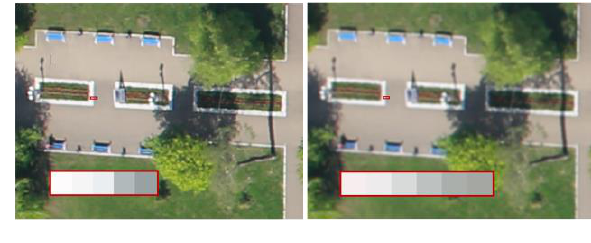
Figure 1. Fragments of aerial images with different sharpness (clarity): the sharpness of the right image is noticeably lower than that of the left image Visually, the blurriness of an image can be estimated by sharp edges of objects by visible pixelation at high magnification. The edge transition is a site of an image (a part of a row/column), containing the sharp change in pixels tone (values) from light to dark on a relatively small pixel interval (about several pixels) (Anikeeva, Kadnichanskiy, 2017). For images of visually high sharpness (clarity), the length of an edge transition does not exceed 5 pixels. If the edge transition is 5 or more pixels long, the image looks blurry, that reduces its interpretation and information properties, it also results in errors in recognition and measuring both in manual and automatic modes (e.g. less accuracy of the correlator). Figure 2 shows an example of edge transitions for sharp blurry image.